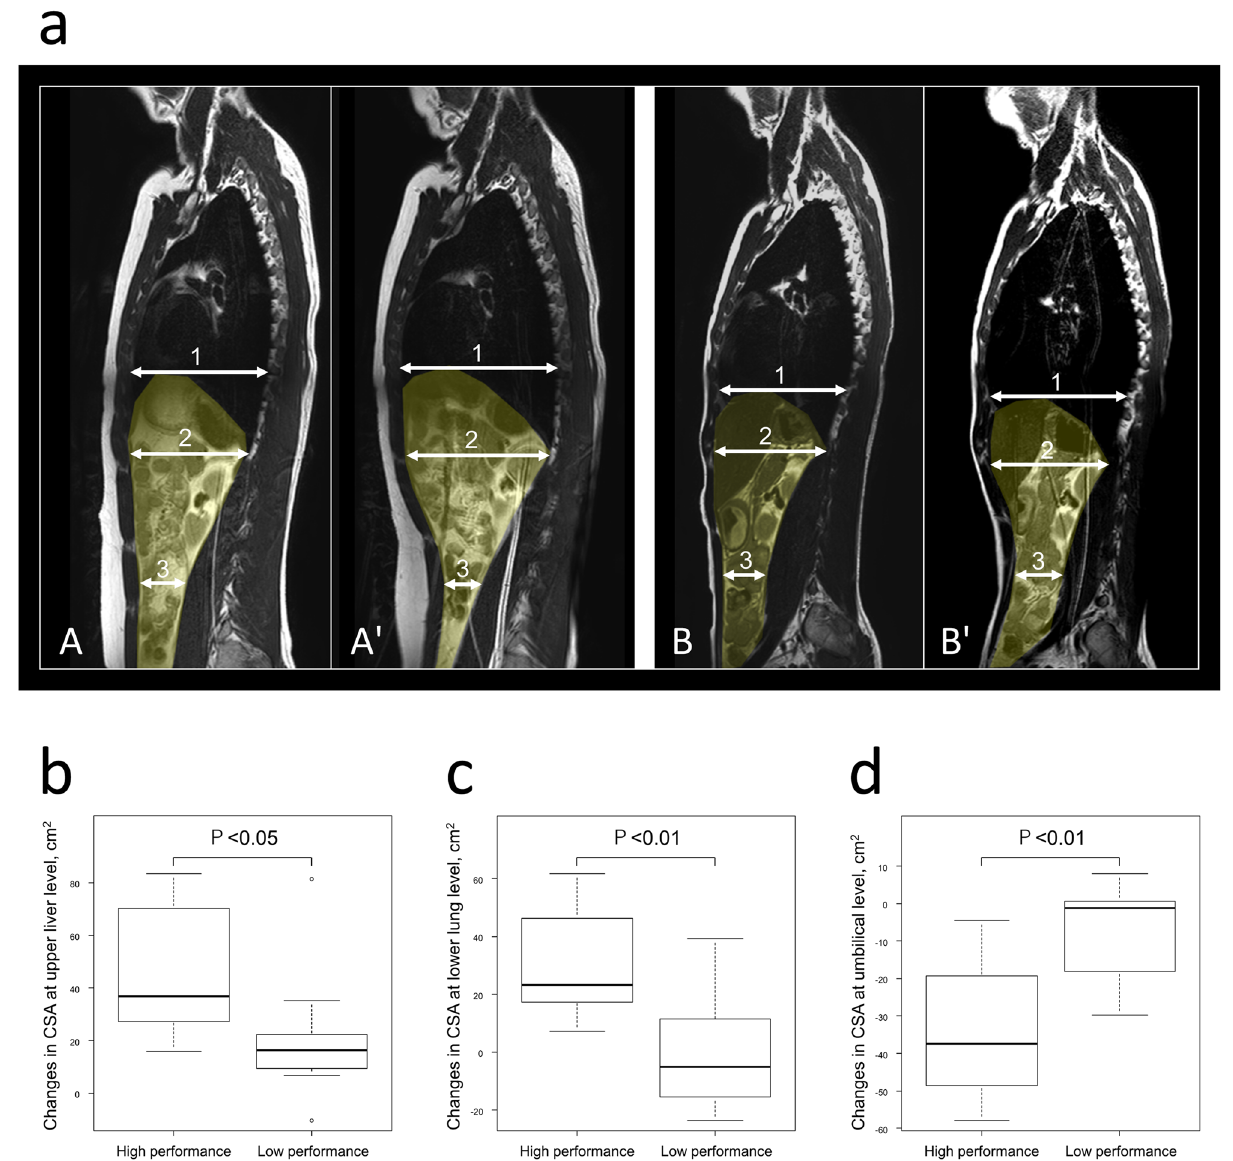
Figure 3. Representative case presentation and changes in CSA between study groups. ( a ) The sagittal MR images at the left kidney level show abdominal cavity, which is marked in yellow. (1) indicates the upper liver level, (2) indicates the lower lung level, and (3) indicates the umbilical level. ( a-A,A’ ) Case 1 is a representative case of the high performance group: the years of swimming practice (YSP) 8 years, gliding distance 13 m. From the resting position ( A ) to the streamlined body position ( A’ ). a-B,B’ , Case 2 is the representative case for the low performance group: YSP 1 year, gliding distance 8 m. From the resting position ( B ) to the streamlined body position ( B’ ). ( b – d ) Box plot of the changes in CSA between the high performance and low performance groups at three levels: upper liver level ( b ), lower lung level ( c ), umbilical level ( d ). Box plots show the median (center line), interquartile range (hinges), 10th and 90th percentiles (whiskers). CSA in the high performance group (as shown in Case 1: a-A, A’ ) increased at the upper liver and lower lung levels, and decreased at the umbilical level in the streamlined body position. These changes in CSA are significantly higher than those of the low performance group at all three levels ( b – d where CG1 is the center of gravity in the streamlined body position, CG2 is the center of gravity in the resting position, RF1 is the center of gravity in the streamlined body position, and RF2 is the center of gravity in the resting position. To perform comparisons between the participants, CGx was expressed as a percentage (CGx%) of each participant’s length between the tip of the longest finger and the soles of the feet as follows: 100 × CGx (3) CGx % = L